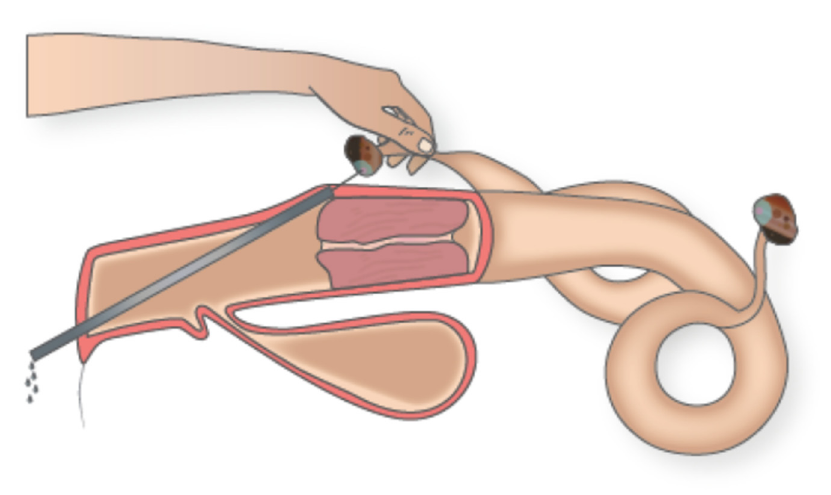
Figure 1. Follicular puncture and drainage with no aspiration of the smaller co-dominant (ovula- tory) follicle using a transvaginal hand-guided metallic cannula in a cow with a follicle of pre- ovulatory size (blue) in each ovary. Drawing by López-Gatius. The color artwork is courtesy of Cris Segú